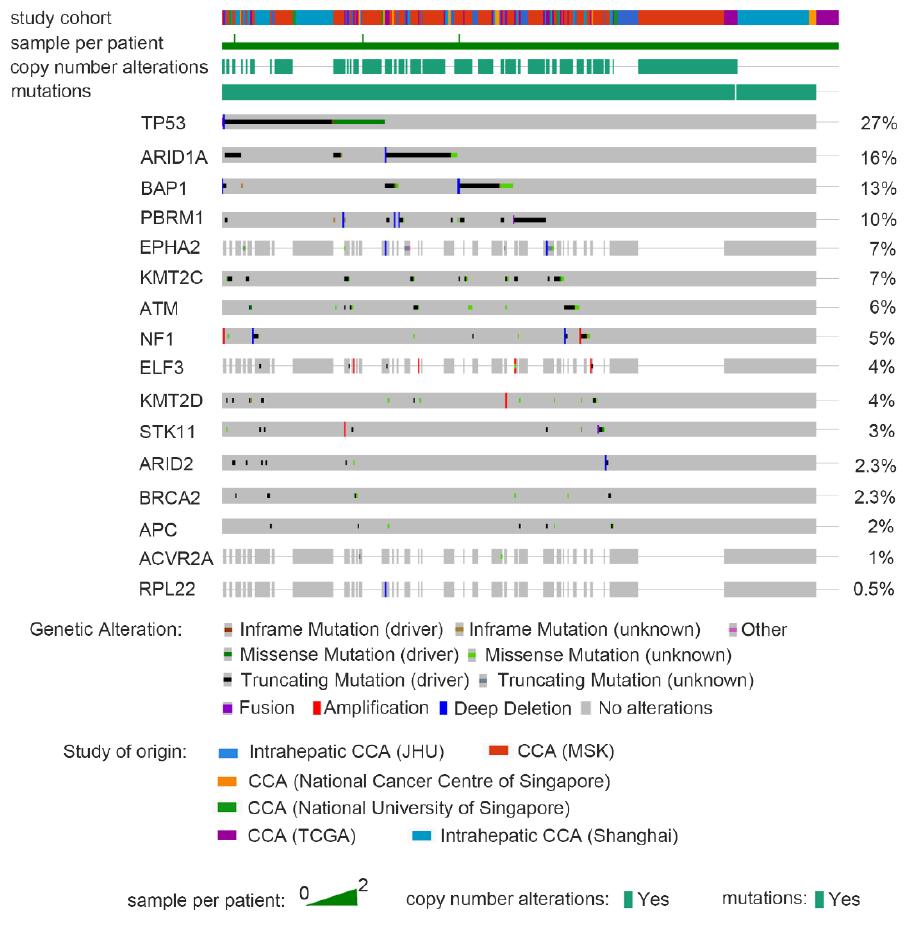
Figure 2. Meta-analysis of genetic alterations in various CCA cohorts. Study recruited six cohorts, including MSK, National Cancer Center of Singapore, National University of Singapore, TCGA, JHU and Shanghai) with a total of 409 patients (412 samples). We summarized the plot by RNA-sequencing of CCA patients on the cBioPortal website. Graph collects the types and patterns of genetic alteration of multiple targets.